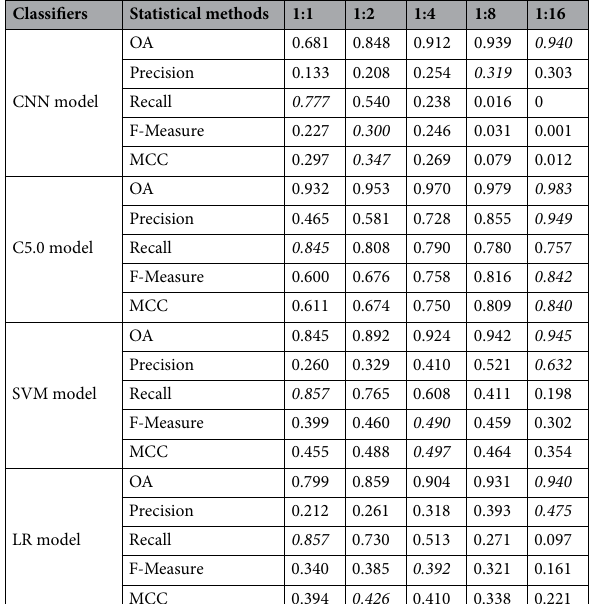
Table 8. The results of five statistical methods. Significant values are in